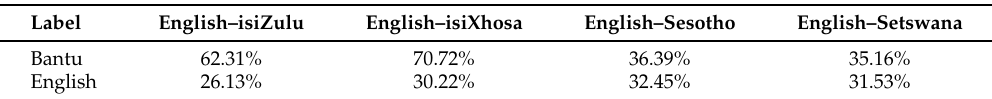
Table 2. Out-of-vocabulary rates for the monolingual corpora when a vocabulary is closed on the four respective bilingual datasets.